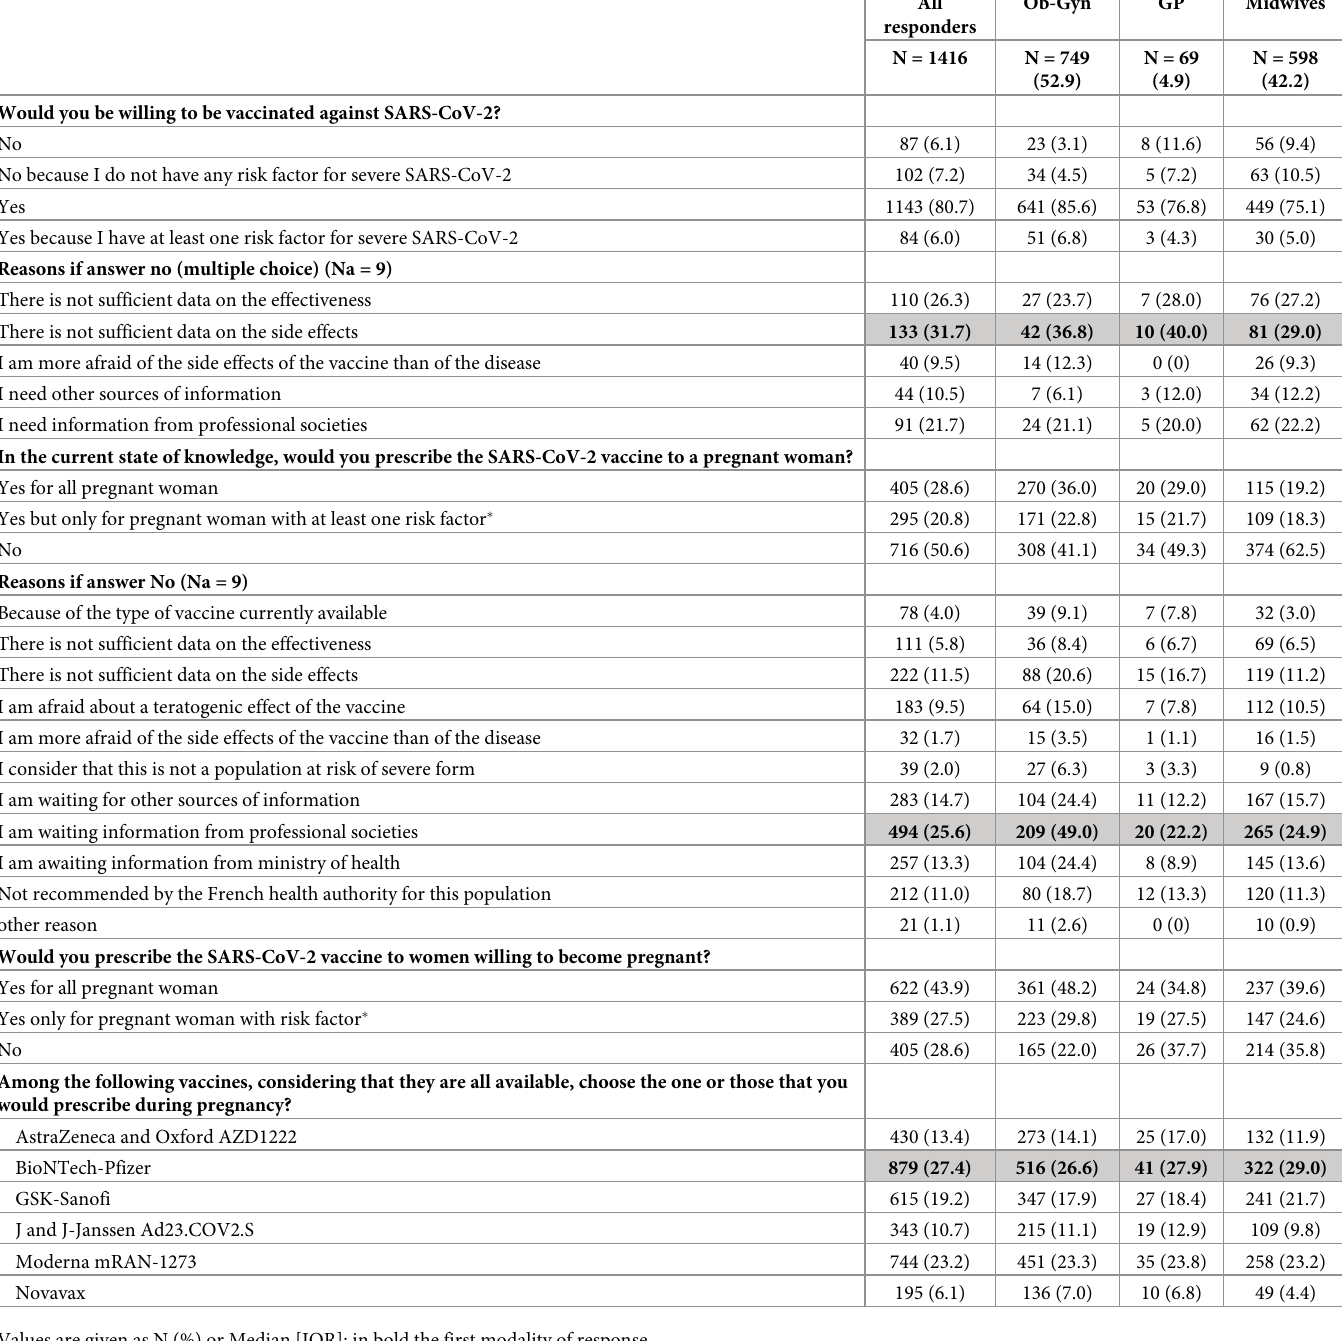
Table 2. Practitioners’ perceptions of the SARS-CoV-2 vaccine.